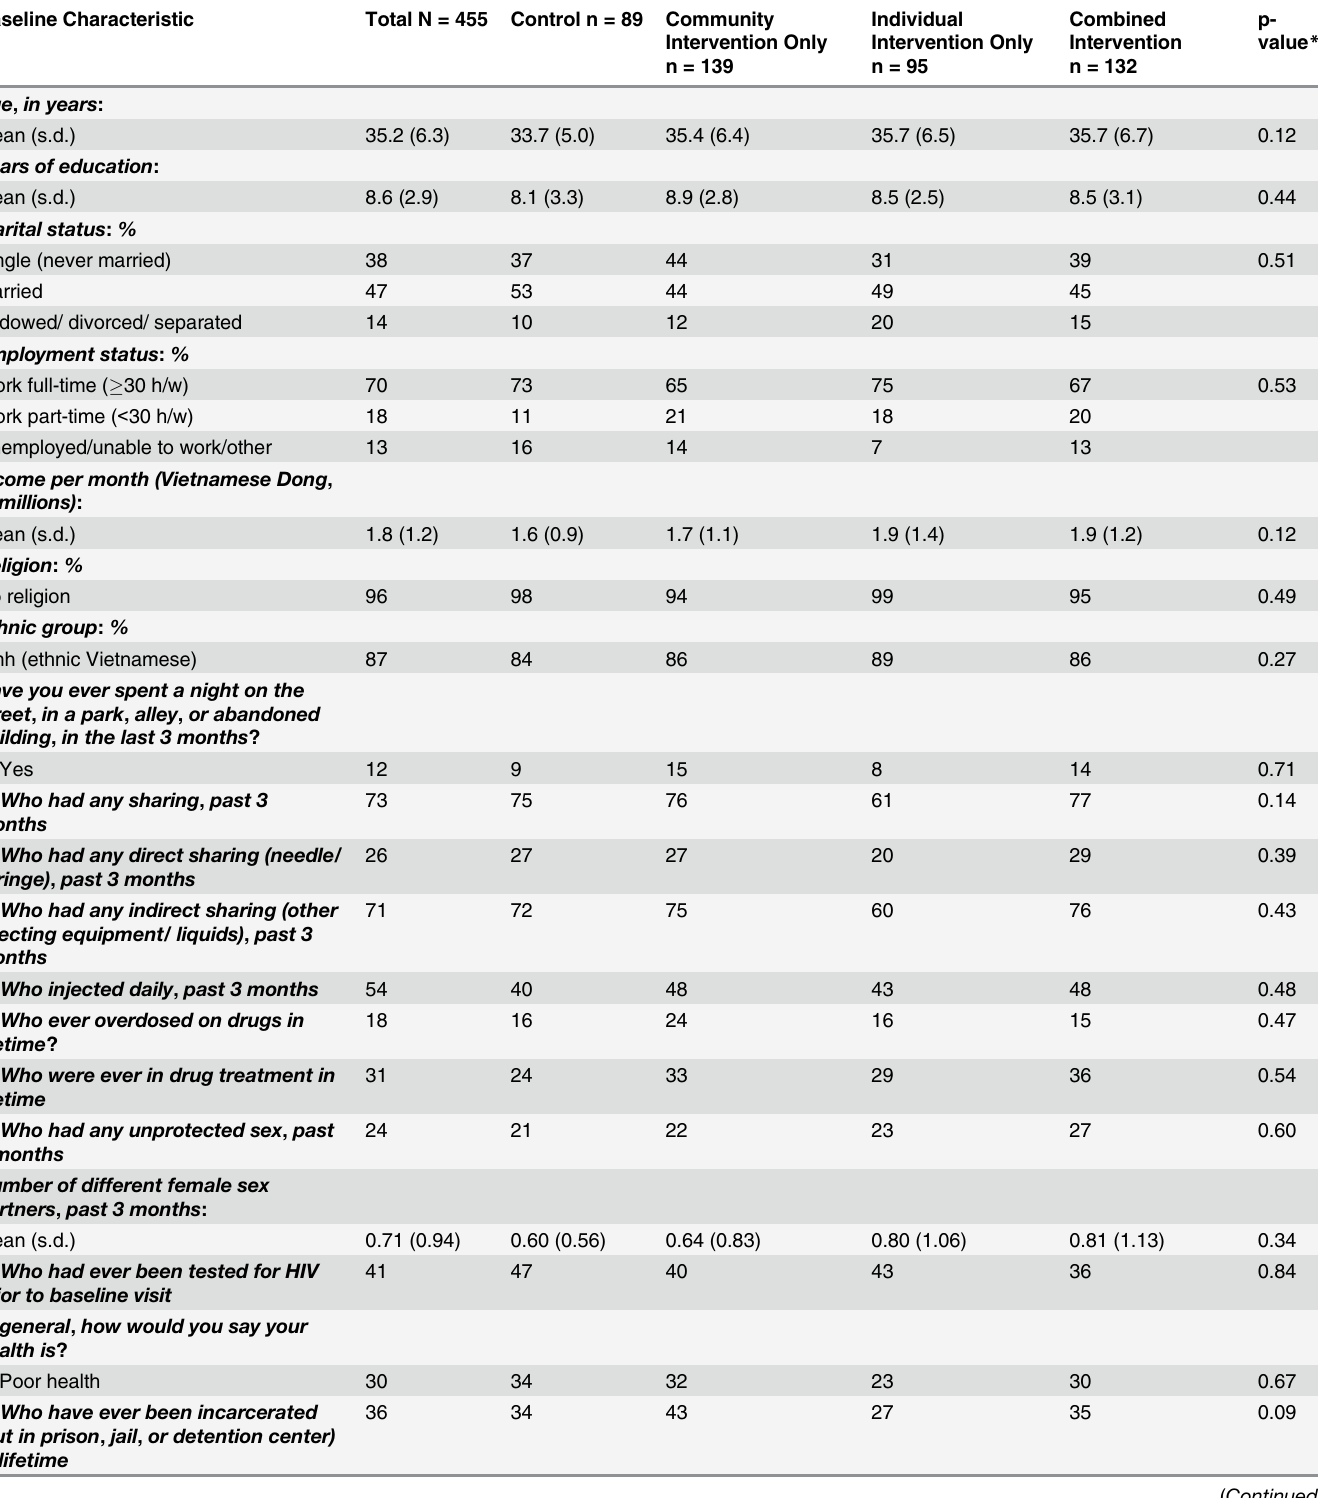
Table 1. Baseline characteristics of enrolled index participants (N = 455), by trial arm. Baseline